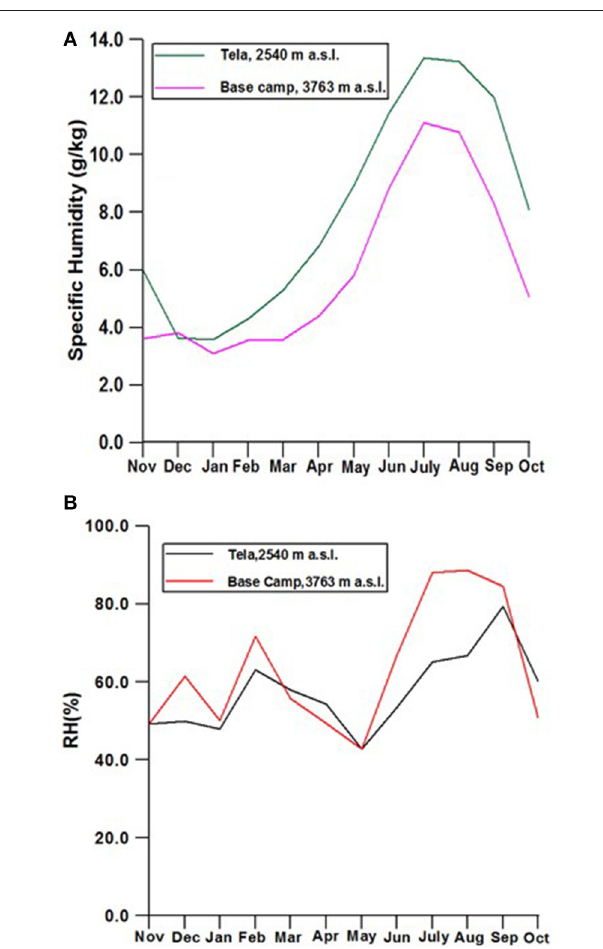
FIGURE 6 | Mean monthly specific humidity variations of (A) lower (2,540m a.s.l.) and upper (3,763m a.s.l.) stations of Dingad catchment and (B) corresponding seasonal variations in relative humidity.